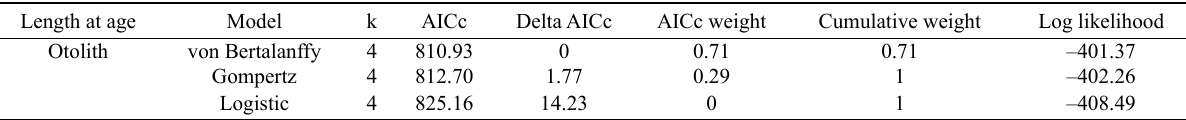
Table 4. – Ranking of parameters of small-sample bias-corrected form of the Akaike information criterion (AICc) estimated for different growth models based on length-at-age data obtained from otolith readings. The best model was selected considering the lowest AICc and highest AICc weight values.